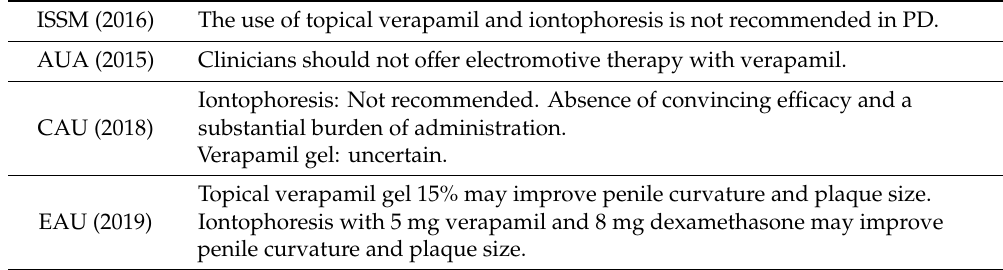
Table 15. Guidelines on Topical Therapy for Peyronie’s